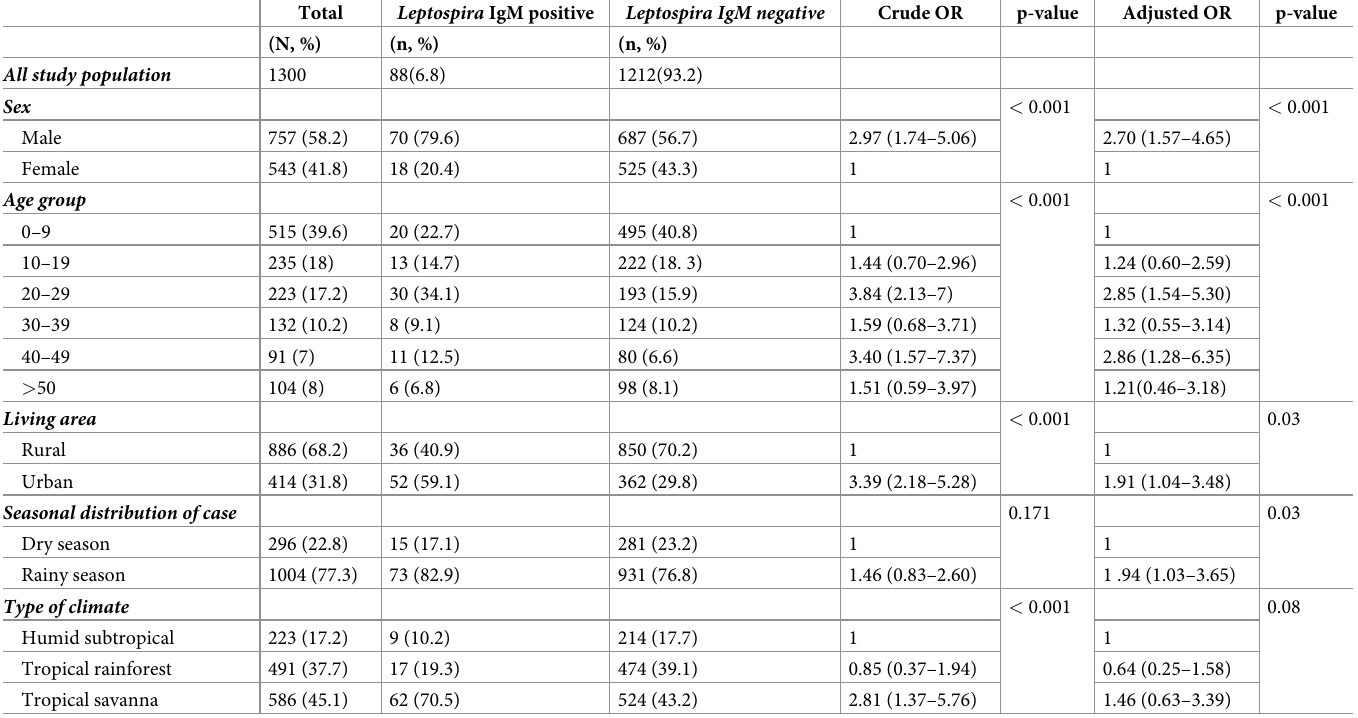
Table 1. Socio-demographic, climate characteristics, and risk factors associated with positive leptospiral serology in DR. Congo